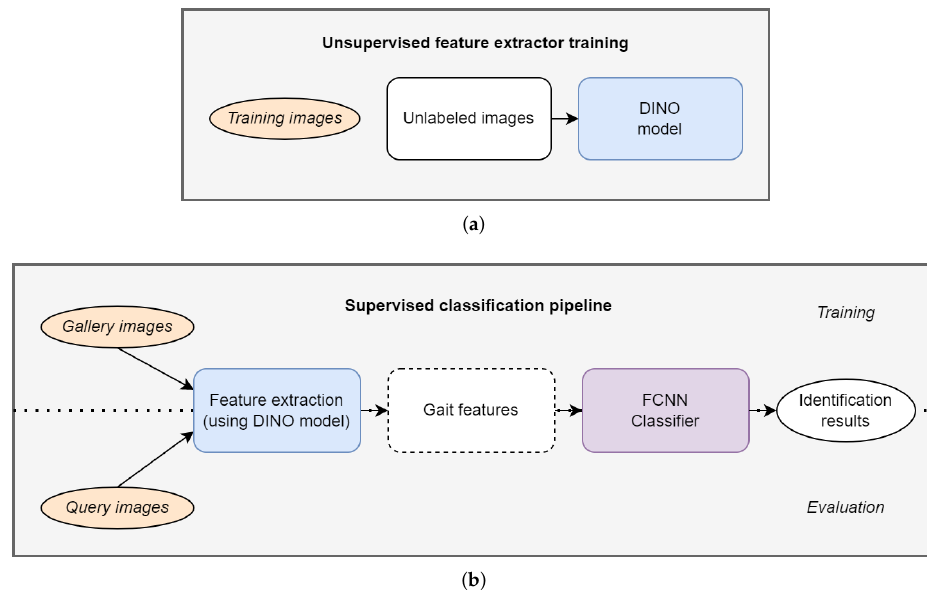
Figure 1. Gait recognition pipeline. ( a ) Training feature extractor. ( b ) Classification